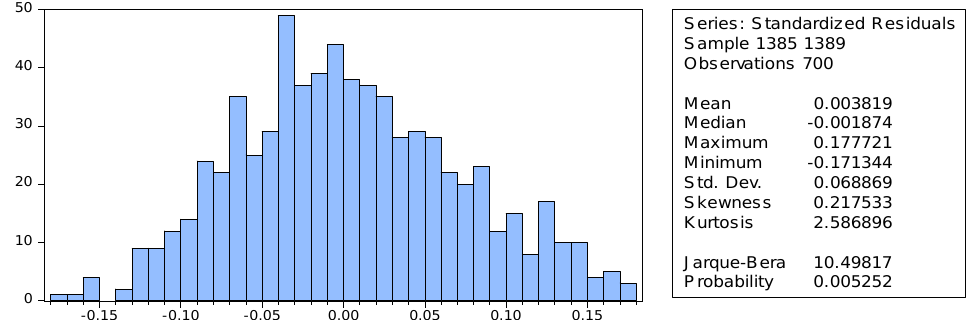
Fig. 1. The results of residuals over the period 2005-2010 (1385-1389 local calendar)